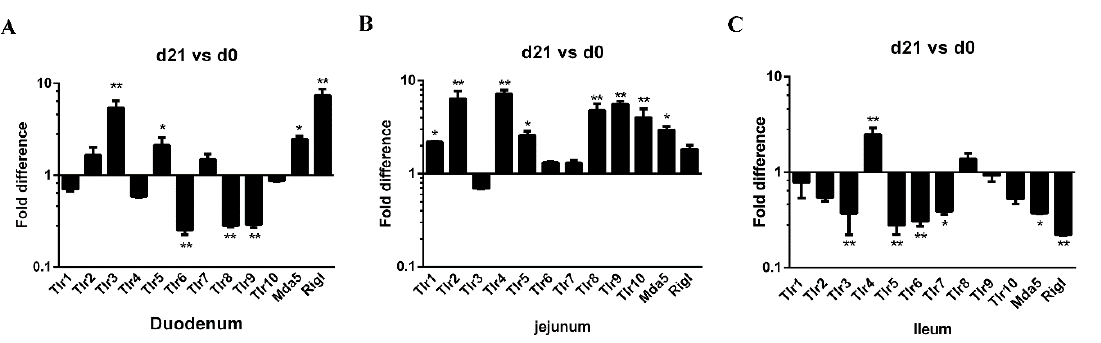
Figure 4. Differences in mRNA expression of PRR genes in neonatal and weaned piglet small intestines. ( A – C ) The mRNA levels of TLR1, TLR2, TLR 3, TLR4, TLR5, TLR6, TLR7, TLR8, TLR9, TLR10, MDA5, and Rig-I in the intestinal mucosa was determined in each animal using a SYBR-green qRT-PCR. All samples were tested in triplicate and the results are expressed as fold changes relative to the control animals. * 0.01 < p < 0.05 and ** p < 0.01.